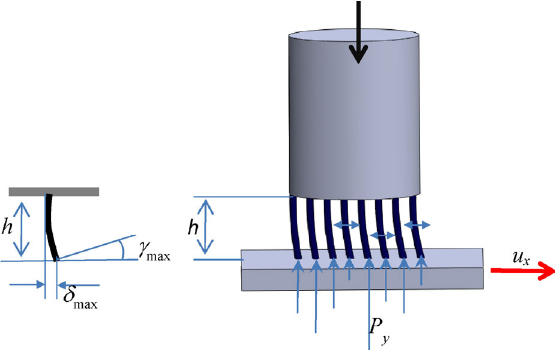
Fig. 14 Simplified model of